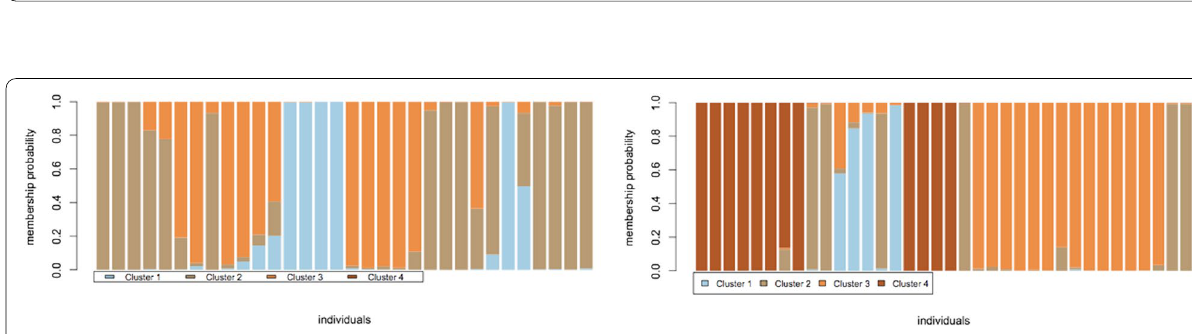
Fig. 3. Cluster based on heatmap, analysis based on SSR data, horizontal axis representing the studied loci and vertical graph of the number of cultivars studied according to Table 1